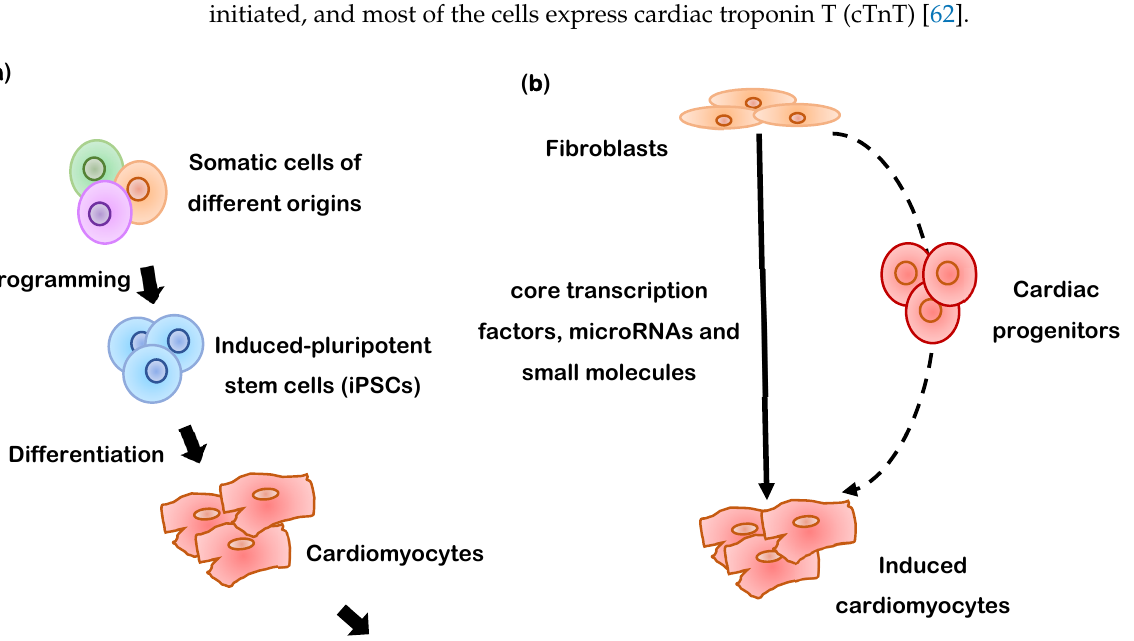
Figure 1 . The two principal methods for generating cardiomyocytes. ( a ) In-Vitro : Somatic cells are reprogrammed into iPSCs, then, the iPSCs are differentiated into cardiomyocyte-like cells which can be directly injected into infarcted myo- cardium or assembled into a patch of engineered cardiac tissue for therapeutic implantation or drug testing. ( b ) In-Vivo: One specific type of somatic cell (typically fibroblasts) is treated with targeted factors to induce transdifferentiation into cardiomyocyte-like cells. ( c ) Generated cardiomyocytes can be delivered as cardiomyocyte patches into damaged heart tissue, or used for drug testing.